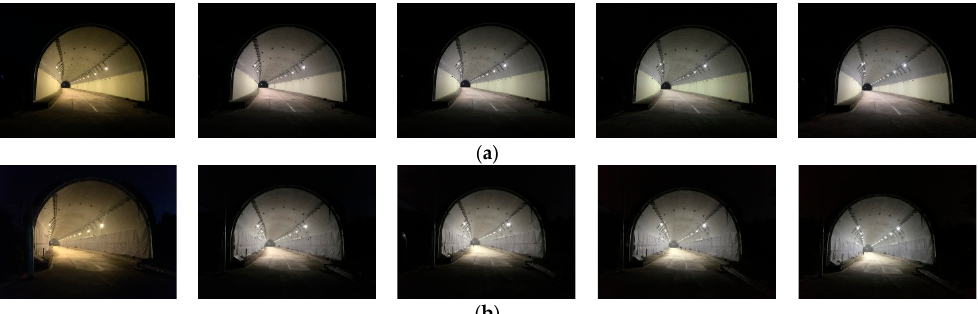
Figure 8. Comparison of lighting environment in tunnel (from left to right: color temperatures of 2500 K to 6500 K). ( a ) Sidewalls with energy ‐ storage and luminescent coating, ( b ) sidewalls with gray cloth.